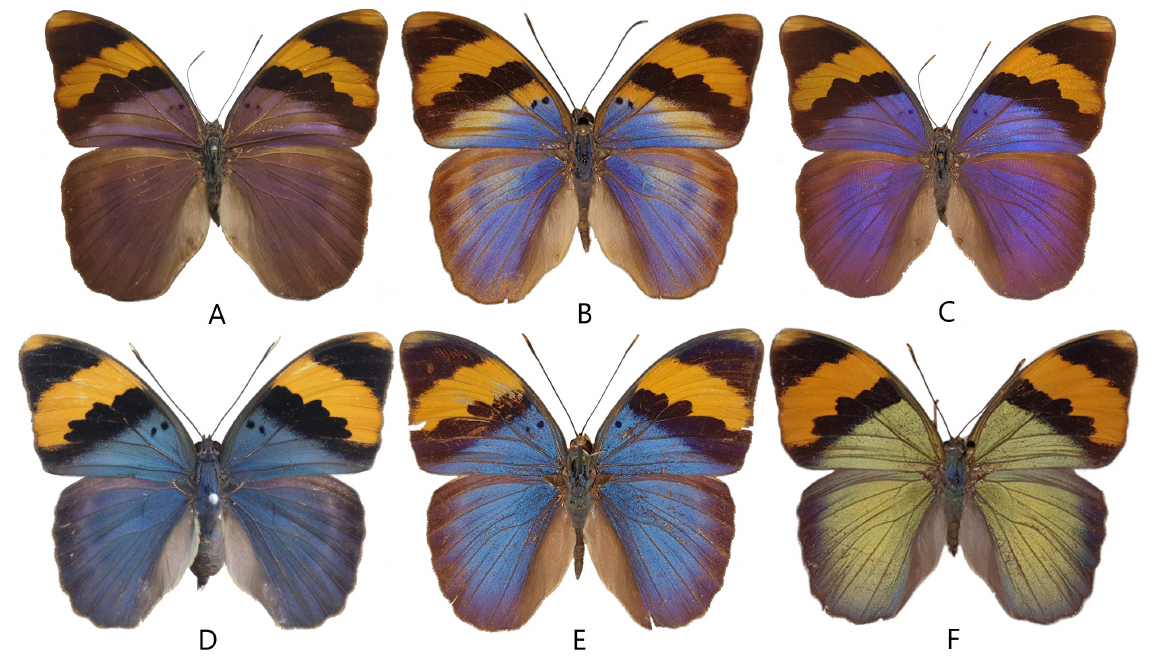
Figure 1. The main morphs of Euphaedra neophron subspecies from violet to green. The dominant colour is indicated as violet (V), blue (B), and green (G): A = E. n. violaceae (V); B = E. n. ellenbecki (V); C = E. n. littoralis (B); D = E. n. rydoni (B), E = E. n. neophron (B); F = E. n. zambesia